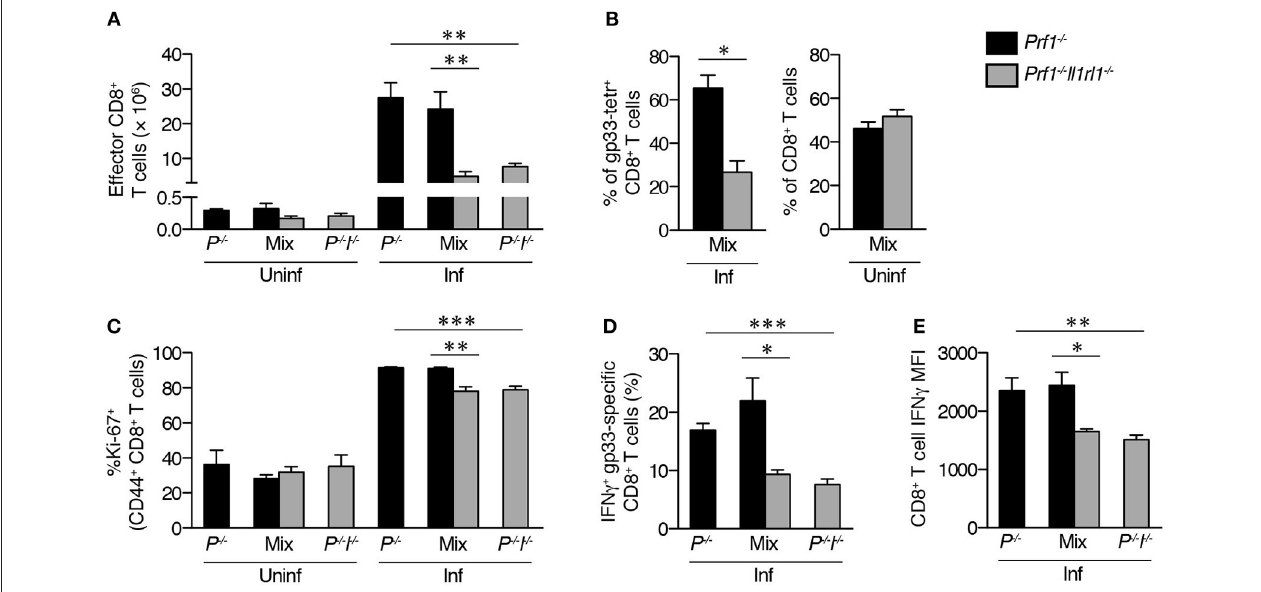
FIGURE 6 | LCMV-specific Prf1 − / − T cells intrinsically require ST2 for enhanced expansion and IFN γ production. BM chimeras reconstituted with cells from Prf1 − / − donors ( Prf1 − / − ), Prf1 − / − Il1rl1 − / − donors ( P − / − I − / − ), or a 1:1 mixture (Mix) were either left uninfected (Uninf) or were infected with LCMV (Inf) and analyzed 8